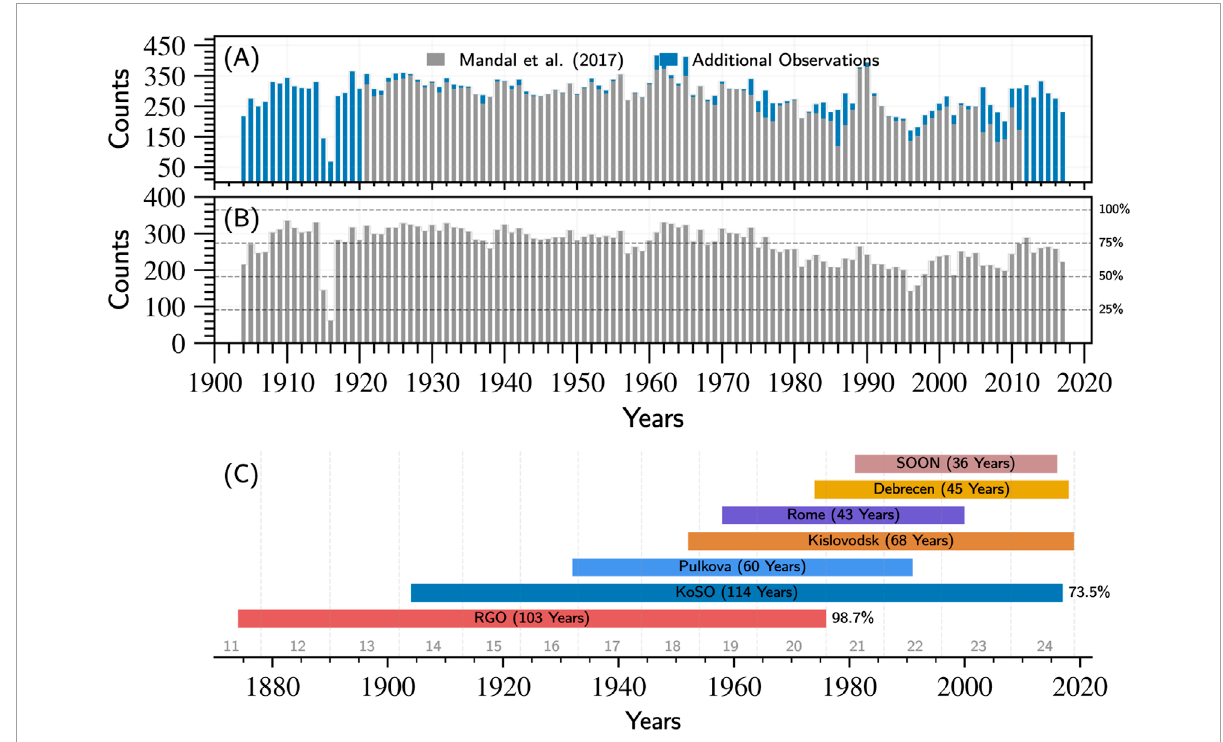
FIGURE 2 Data statistics showing (A) the number of observations per year for each year where two colours (grey) data used in Mandal et al. (2017) and (blue) the additional observation that has been added to the series; (B) the number of observing days in a year after including all the data for 1904–2017. (C) Is showing the data coverage for different observatories, including KoSO and RGO.